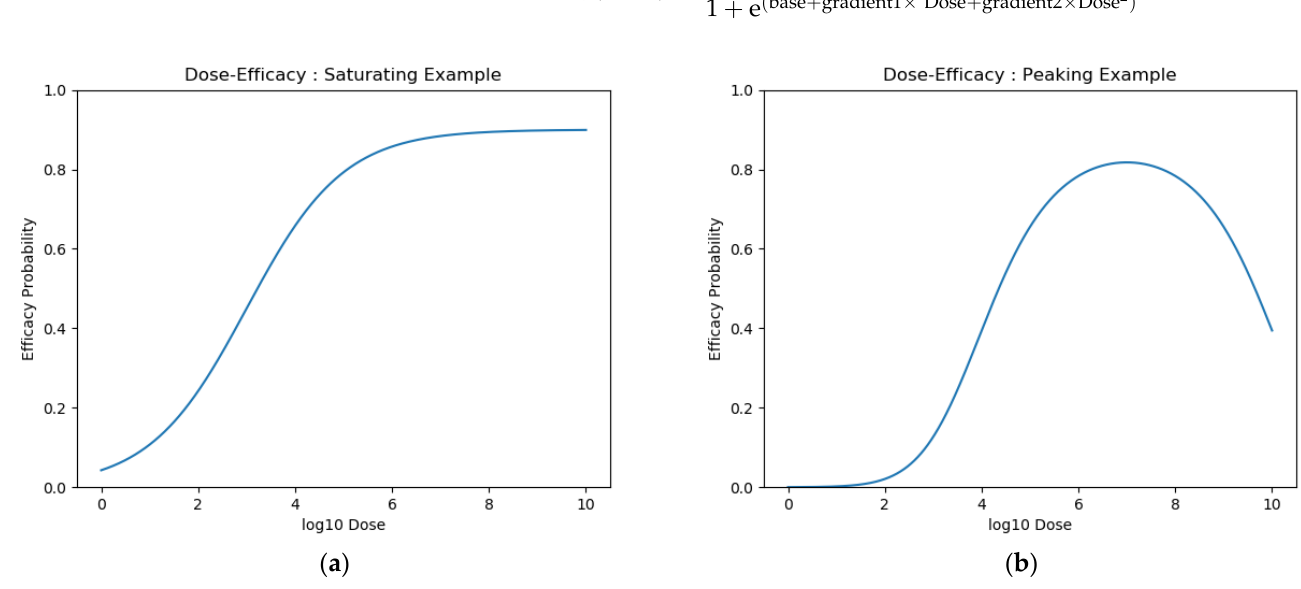
Figure 2. Example curves for ( a ) saturating and ( b ) peaking dose efficacy.